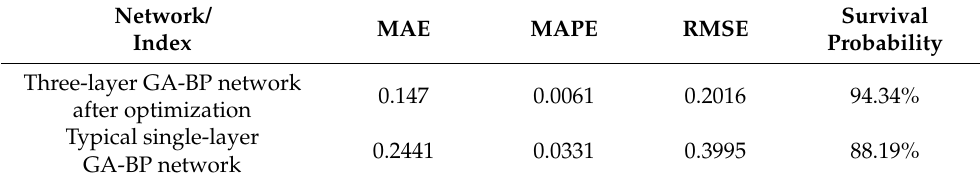
Table 2. The optimized neural network